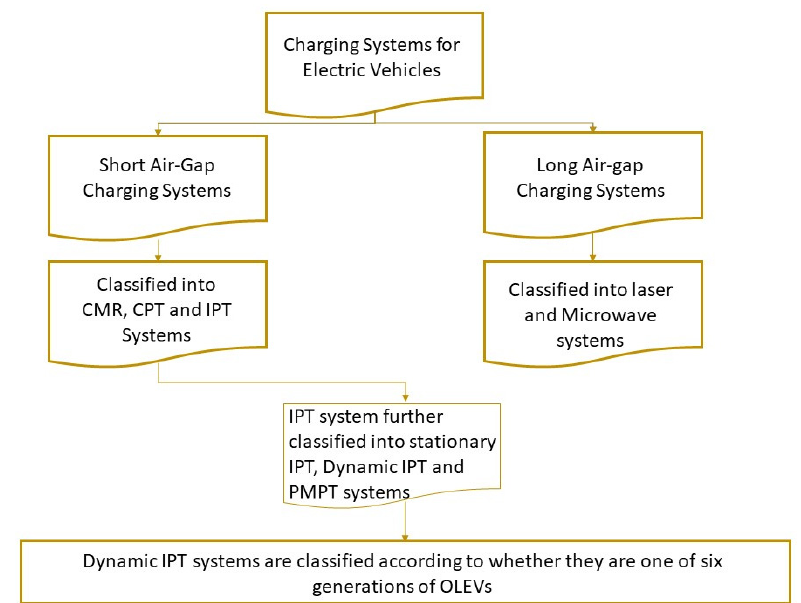
Figure 1. General Classification of EV Charging Systems (Adapted from [9]). CMR—Coupled Magnetic Resonance; CPT—Capacitive Power Transfer; IPT—Inductive Power Transfer; PMPT—Permanent Magnet Power Transfer; OLEVs—Online Electric Vehicles.